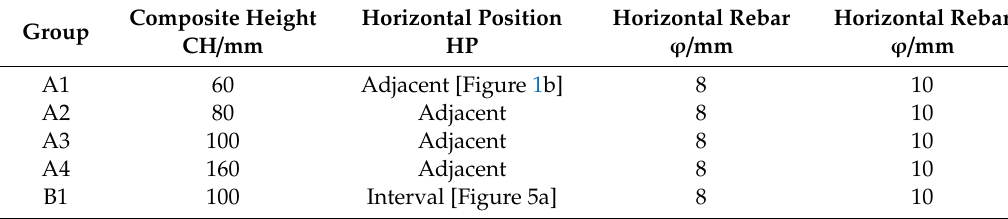
Table 1. List of specimens.